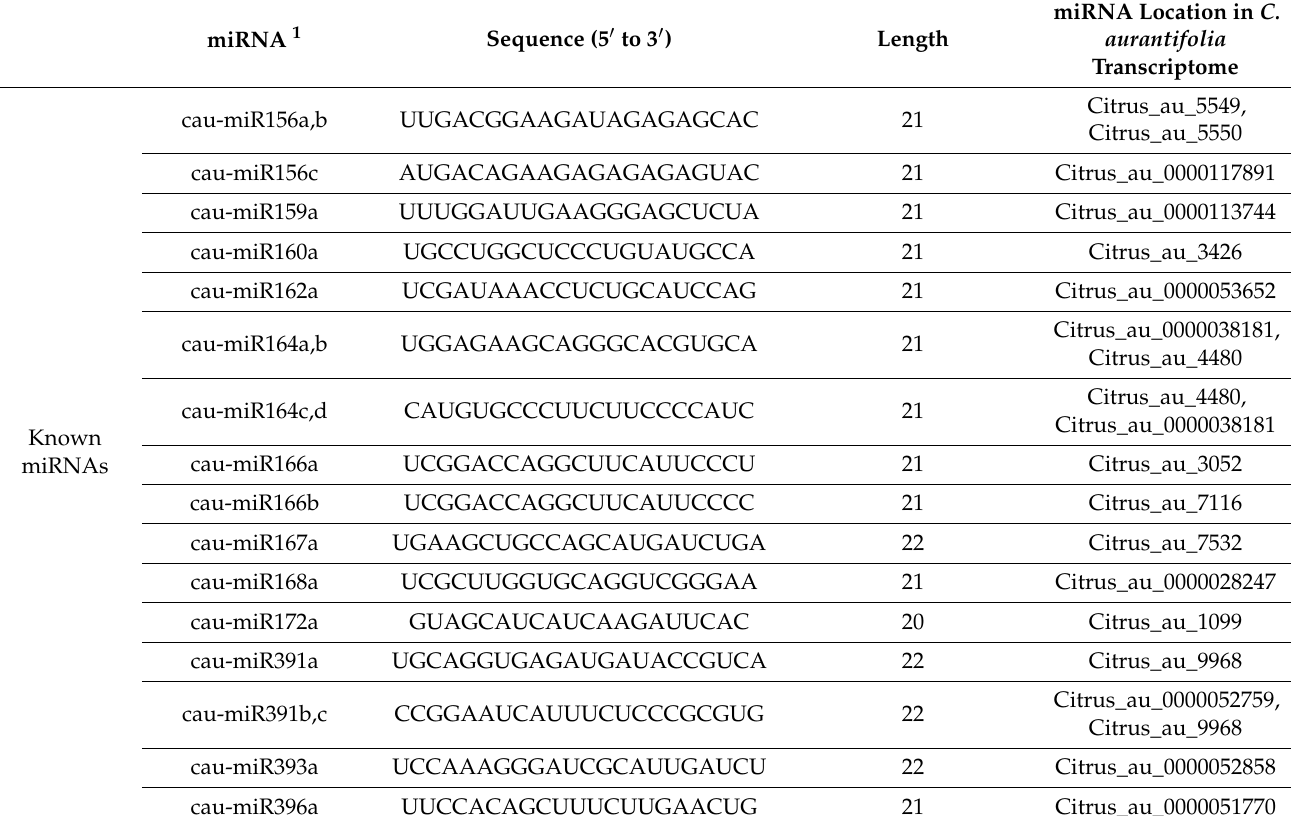
Table 2. Known and novel miRNA sequences identified in Mexican lime.